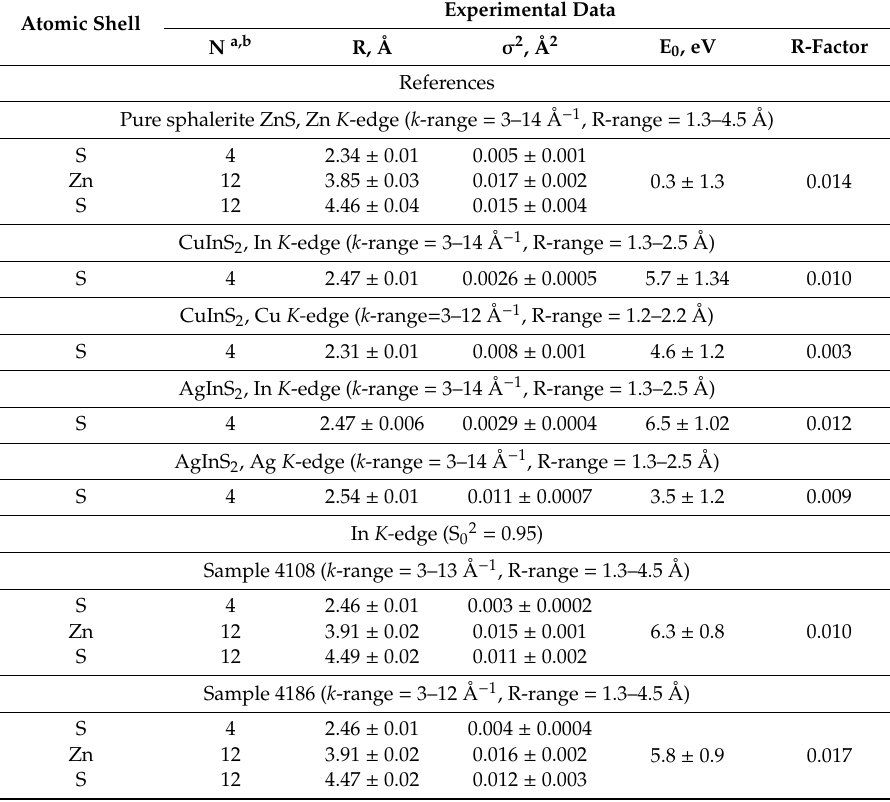
Table 3. Structural parameters derived from the EXAFS